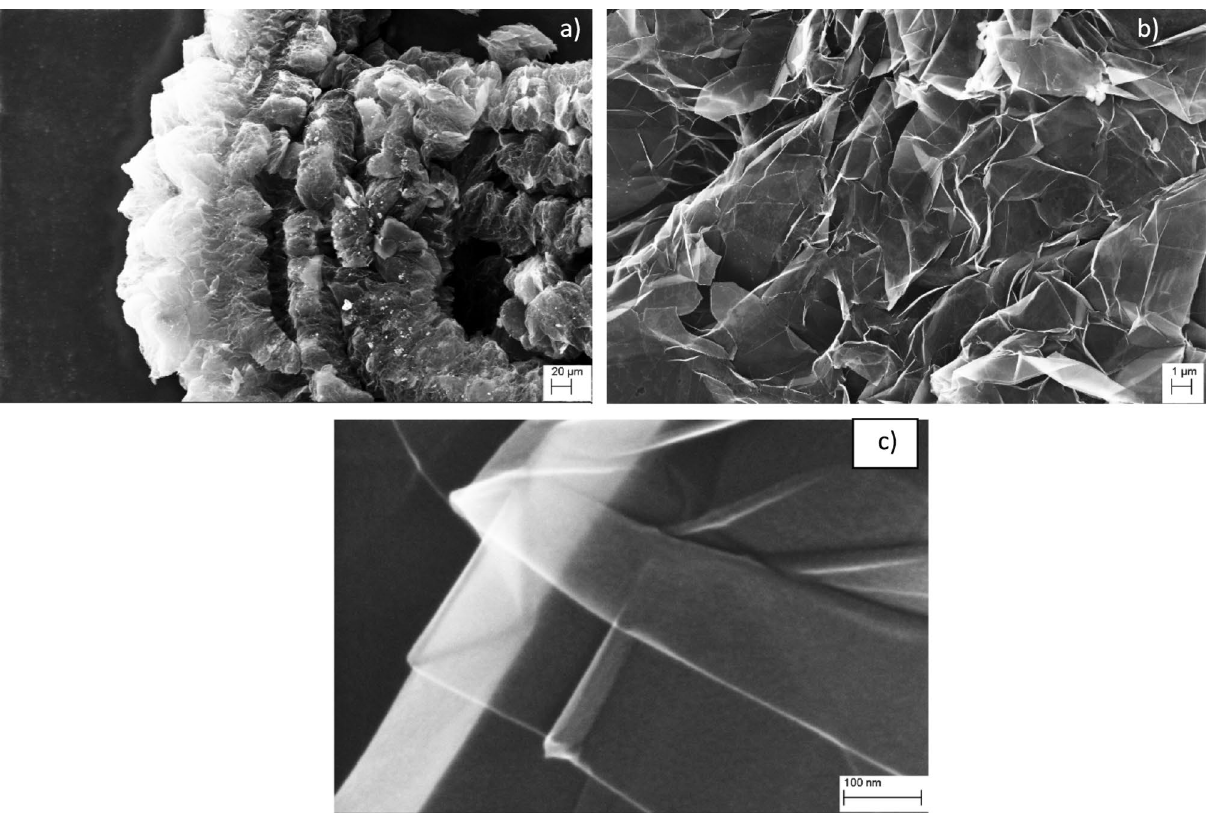
Figure 1. SEM images of the TPEG with different magnification ( a : 500 ×, b : 10,000 ×, c : 390,400 ×).